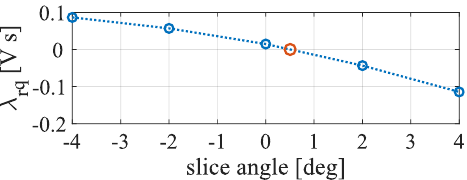
Figure 9. Rotor flux linked with the β r winding ( λ rq = λ r β with the rotor current imposed according to